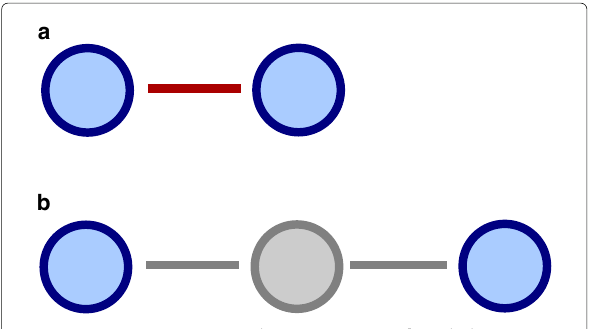
Fig. 3 Contact types in principle. a Point-2-point b